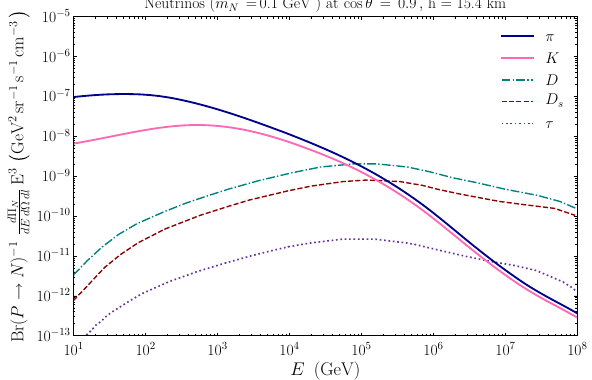
Fig. 1 HNL production rate (for m N = 0 . 1 GeV) per energy, solid angle and path length, at a height of 15.4 km and cos θ = 0 . 9, for different parent particles P . In this work, we consider only π and K decays. For comparison we also show the corresponding result for two- body decays of heavier mesons ( D , D s ) and leptonic (three-body) τ decaysfromRef.[24].Foralllinesshownhere,effectsduetothemassof thechargedleptonproducedtogetherwiththeHNLhavebeenneglected for